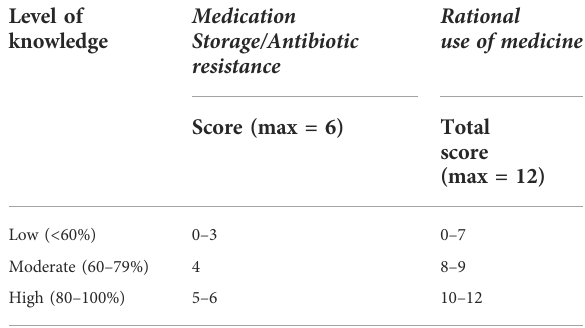
TABLE 2 Classi fi cation of level of knowledge.